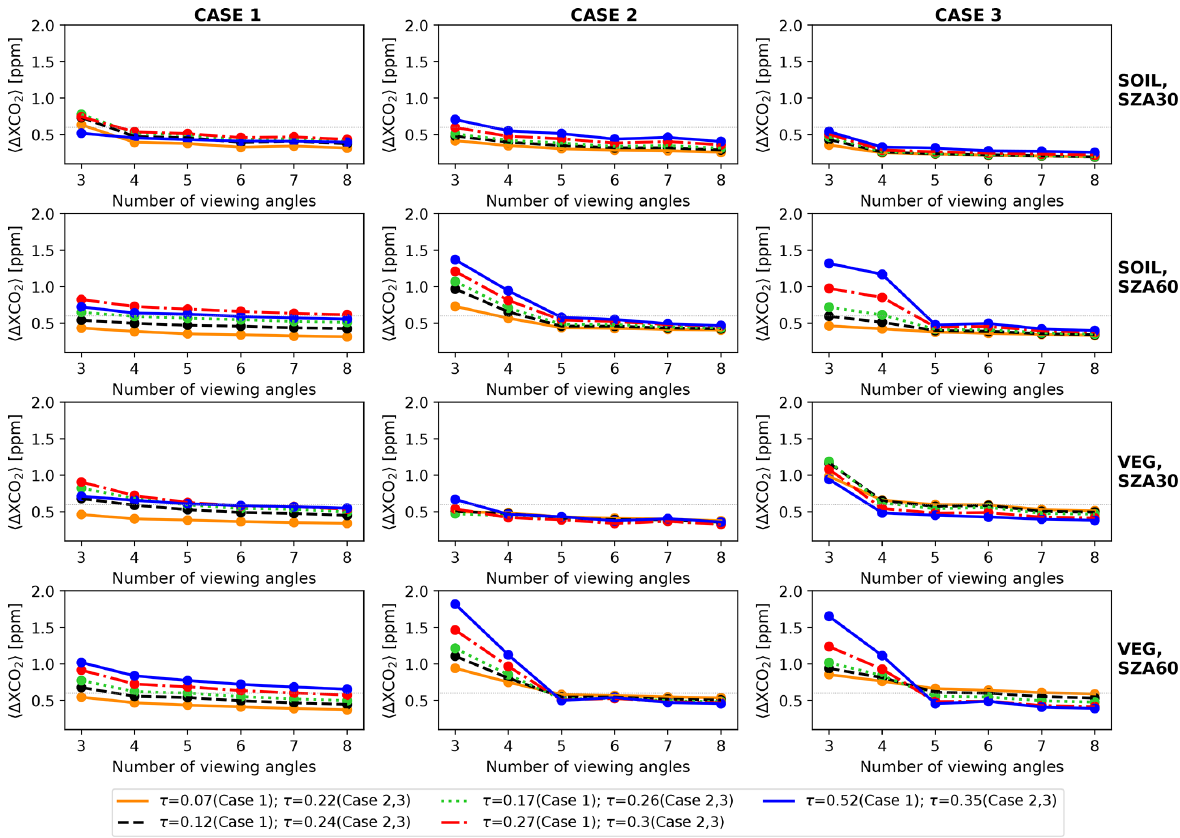
Figure 4. (cid:104) (cid:49) XCO 2 (cid:105) as a function of number of viewing angles for all 60 study scenarios. The five lines in each panel represent different values of total aerosol optical depth at 765nm. (cid:104) (cid:49) XCO 2 (cid:105) is computed for the MAP-mod concept with (cid:49)I/I = 3% and (cid:49) DLP = 0 . 003. The MAP-mod spectrum for each scenario extends from 385 to 765nm.